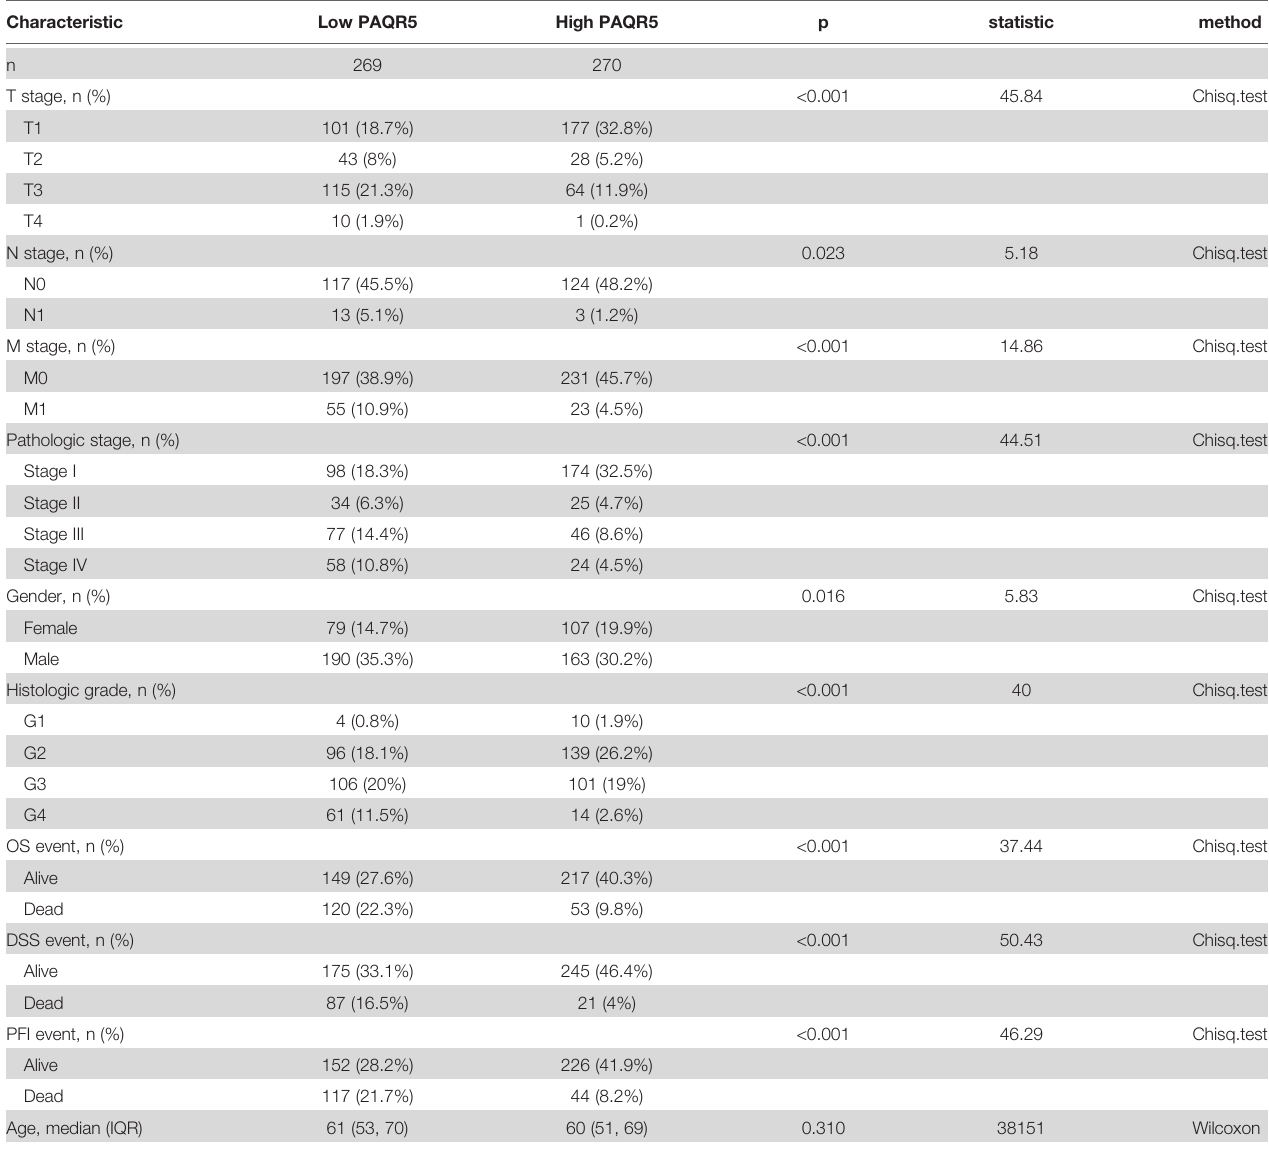
TABLE 1 | Association of PAQR5 expression with clinicopathological parameters in ccRCC patients.